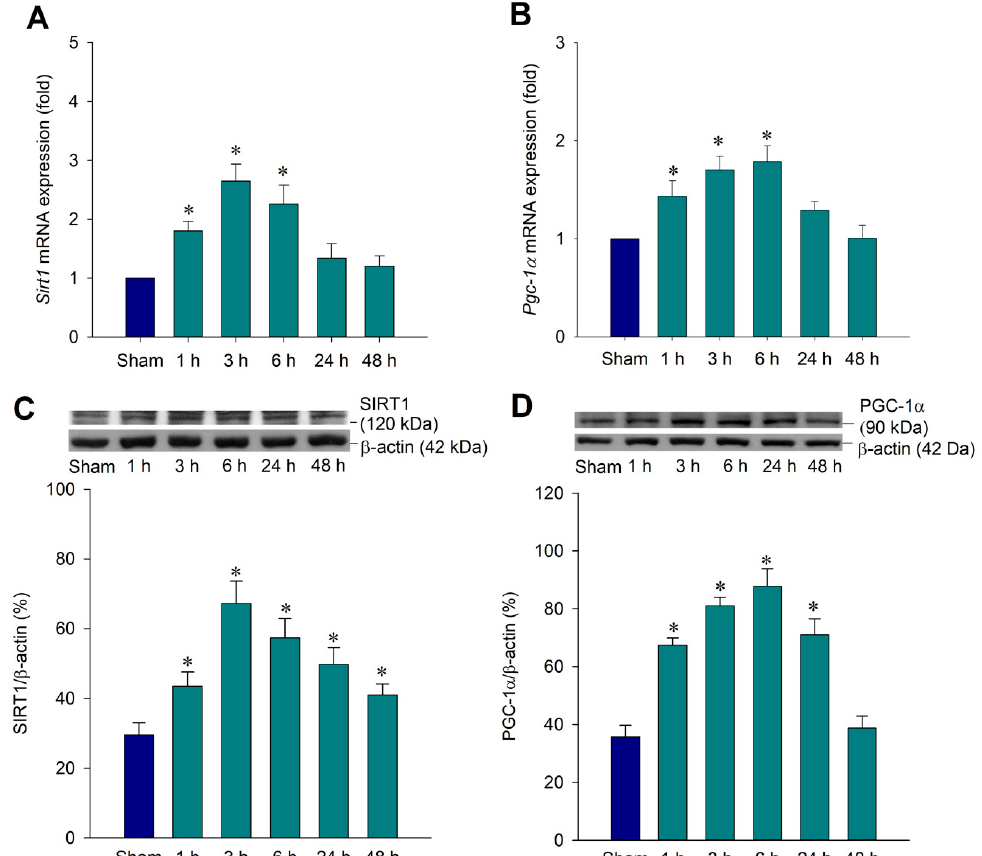
Figure 1. Upregulation of the expression of SIRT1 and PGC-1 α mRNA and proteins after the microinjection of kainic acid (KA) in the hippocampal CA3 subfield. Upregulation of the expression of Sirt1 mRNA ( A ) and Pgc-1 α mRNA ( B ) detected in samples were collected from the right CA3 subfield of the hippocampus at 1, 3, 6, 24, or 48 h after the microinjection of 0.5 nmol KA into the left hippocampal CA3 subfield or sham animals. Representative gels (inset) or changes in SIRT1 protein ( C ) and PGC-1 α protein ( D ), relative to β -actin, detected in samples were collected from the right CA3 subfield of the hippocampus under the same experimental conditions. Values are the mean ± standard error of the mean (SEM) of quadruplicate analyses from six animals per experimental group. * p < 0.05 versus the sham-control group in the Sche ff é multiple-range